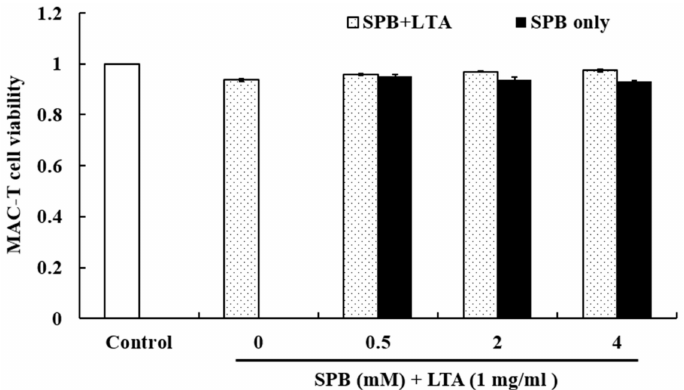
Figure 1. The effect of SPB on the cell viability of MAC-T cells. MAC-T cells were cultured in the presence of SPB (0.5, 1, 2, and 4 mM) and LTA (1 mg/mL) for 24 h, and then viability was determined by MTT assay. Each data point shows the mean ± standard error (SE) of triplicates from three independent